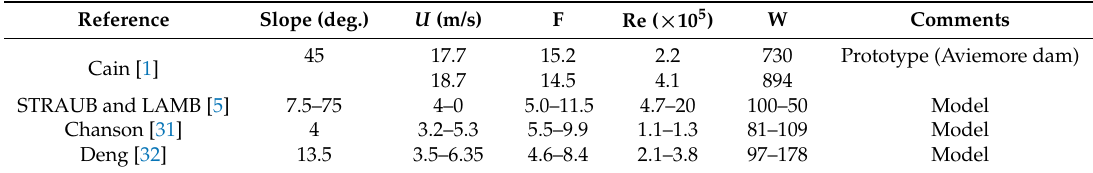
Table 2. Experimental investigations of self-aerated